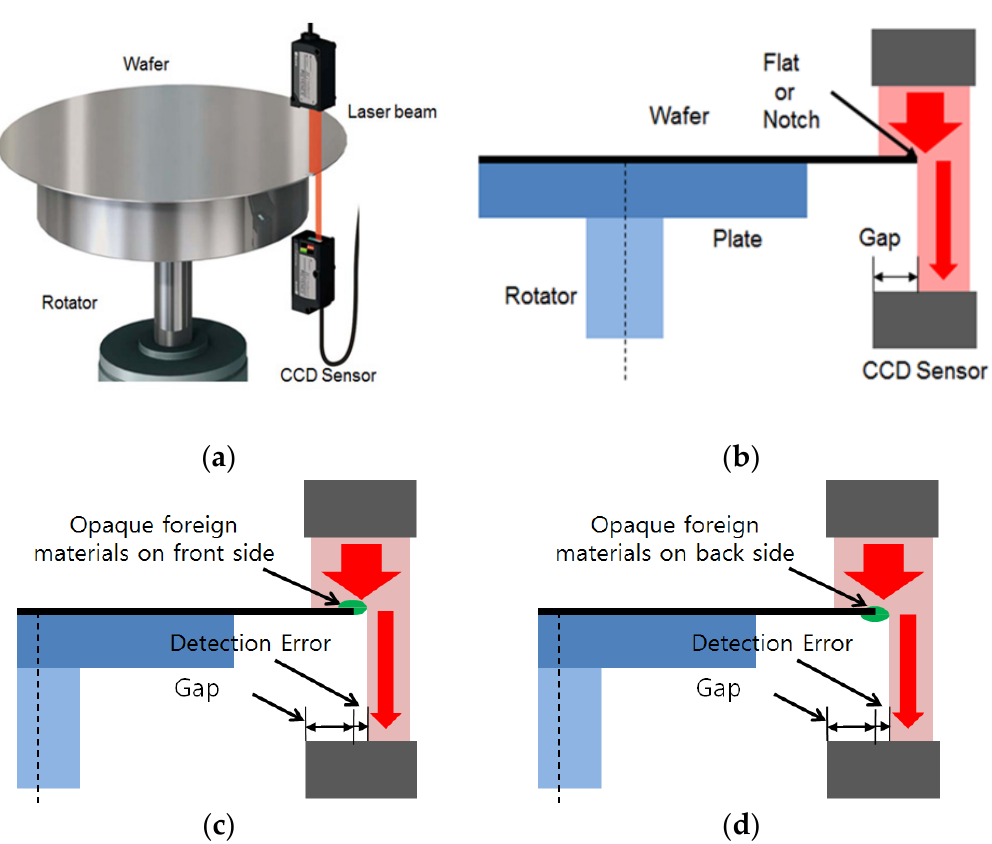
Figure 1. Conventional method for the detection of a wafer flat or notch. ( a ) Wafer aligner; ( b ) normal operation; ( c ) detection error case No. 1; ( d ) detection error case No. 2.